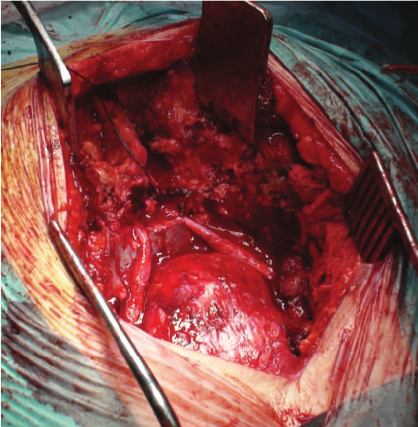
Figure 12: S2 nerve roots were preserved and remained intact along their entire length.